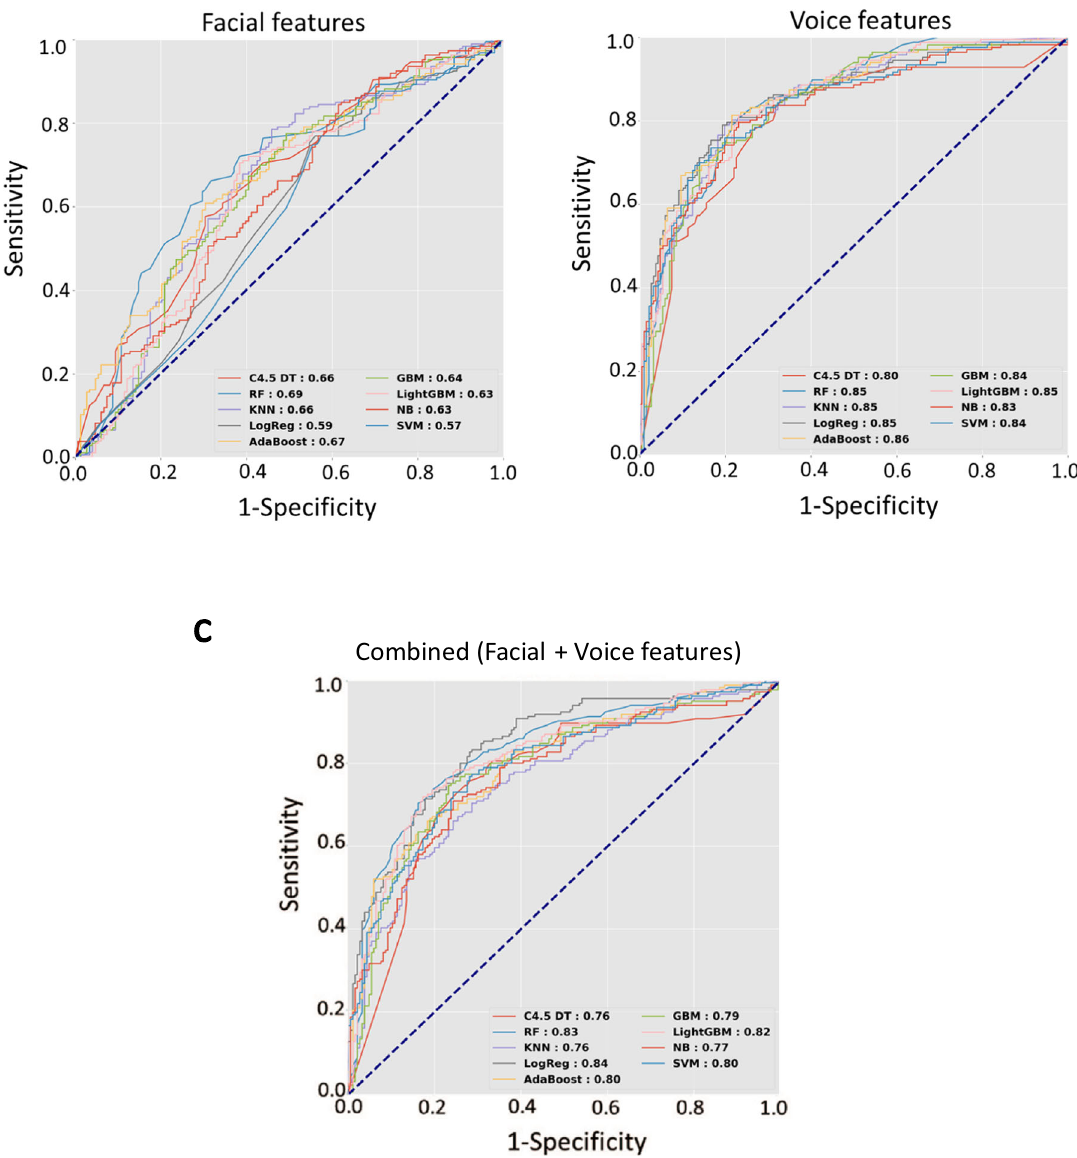
Fig. 1 Receiver operating characteristic curves calculated with nine deep-learning classi fi er models. The models were used to evaluate the predictive value of either a facial features alone, b voice features alone, or c combined both features. The area under the curve indicates the ability to differentiate between the entire patient cohort and the controls, in the training